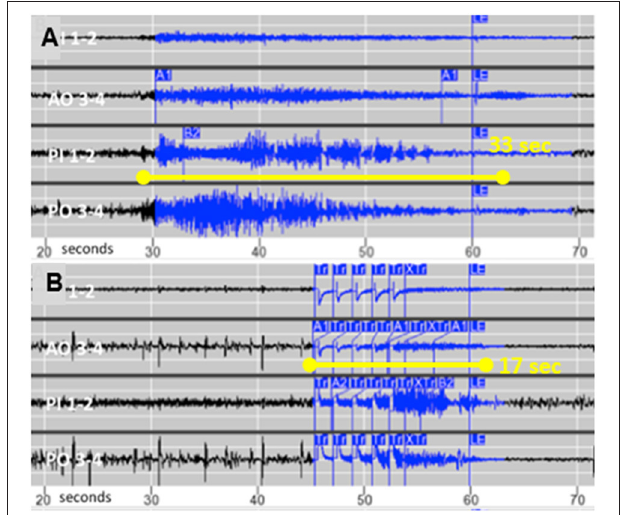
FIGURE 2 | (A) Typical seizure recorded from chronic intracortical electrodes prior to activating stimulation and (B) The typical shortened seizure with less propagation following optimization of stimulation